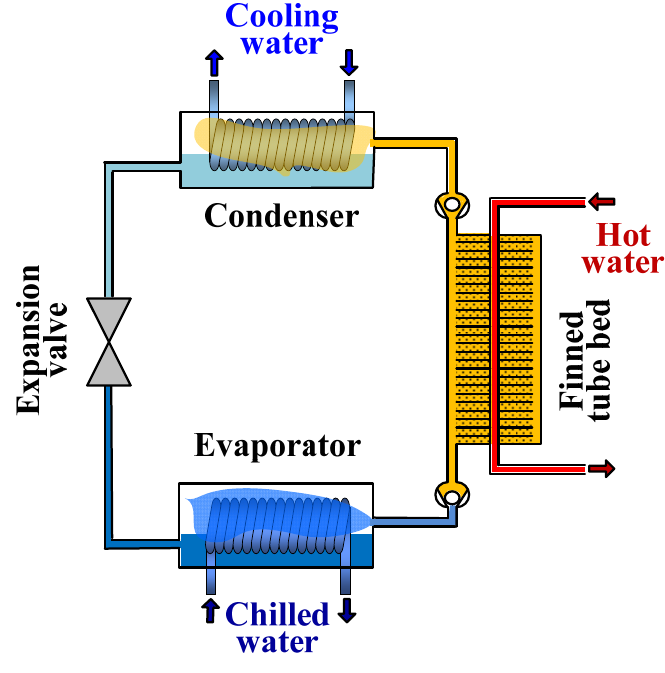
Figure 1. Schematic of adsorption cooling system in desorption process.